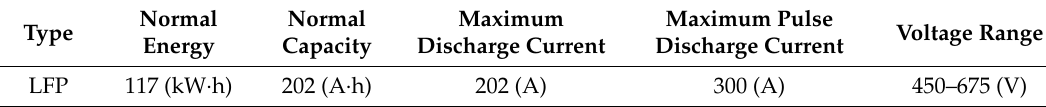
Table 3. Parameters of the power battery.